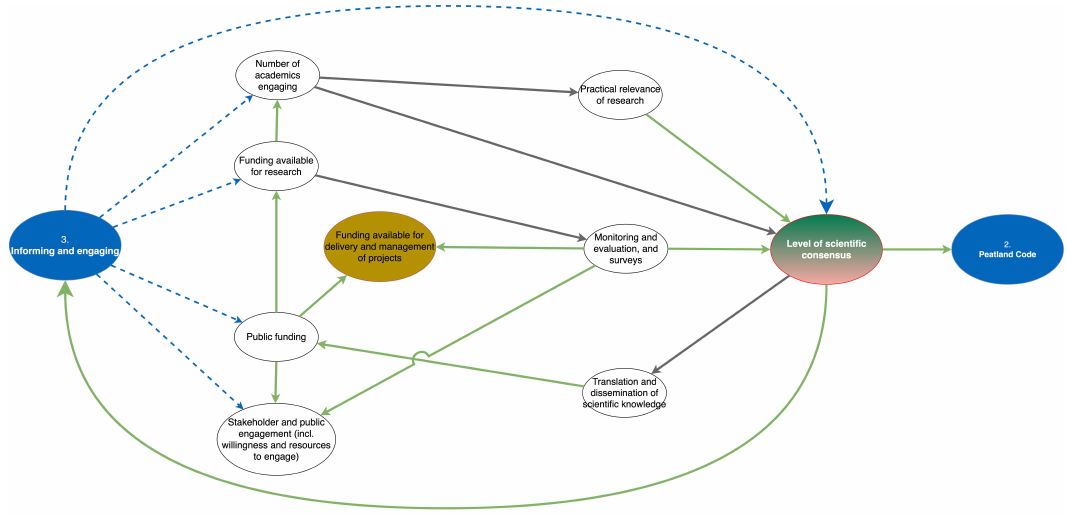
Figure 4. Submap tracing causal flow from ‘Informing and engaging’. This bespoke submap was created to show the path between ‘Informing and engaging’ and ‘Level of scientific consensus’ and the related nodes reflecting material from the